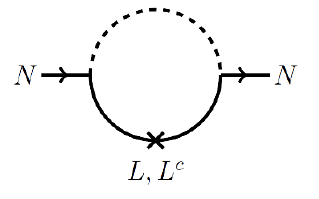
Figure 3 . Loop correction to m N